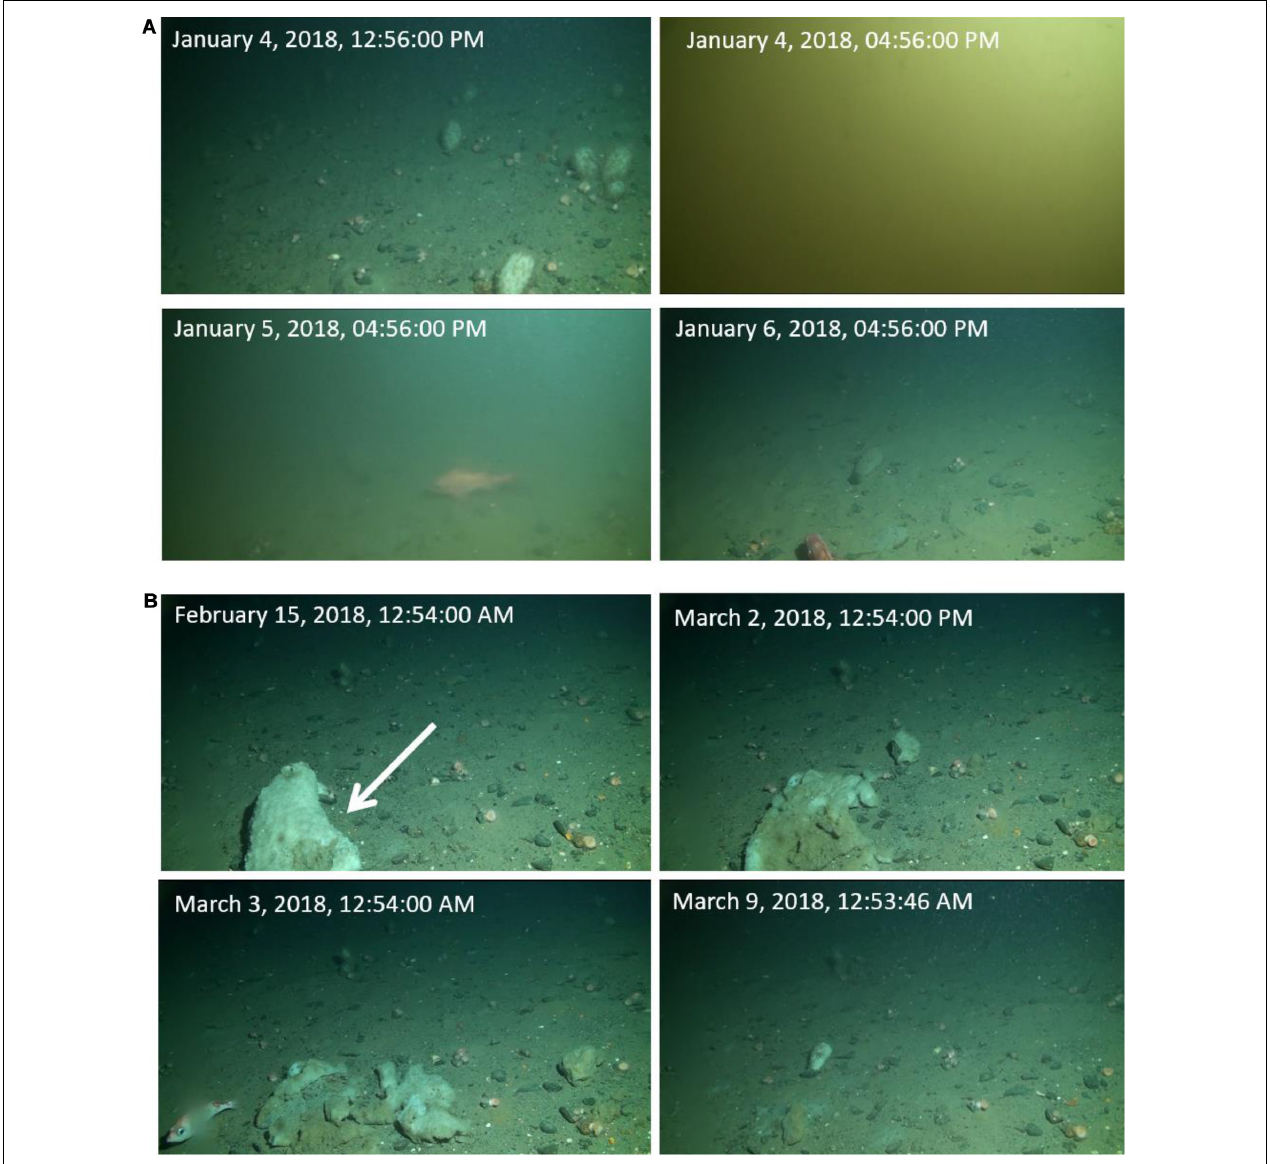
FIGURE 8 | Photographs showing the camera view (A) before, during and after the storm event (4. January). Large amounts of suspended matter were observed in the benthic boundary layer from the 4. January to the 7. January; (B) Dead sponge in February indicated by a white arrow and its subsequent decomposition until its barely detectable at the 9th of